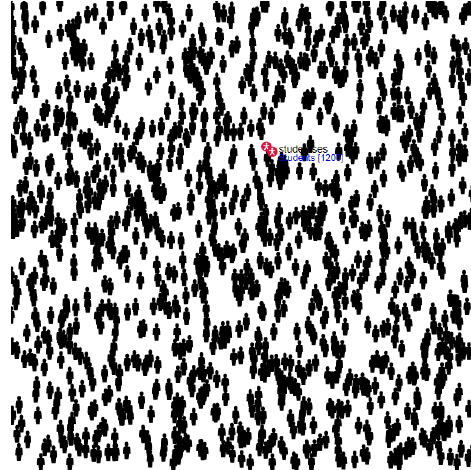
Figure 4: Distribution of agents in a given